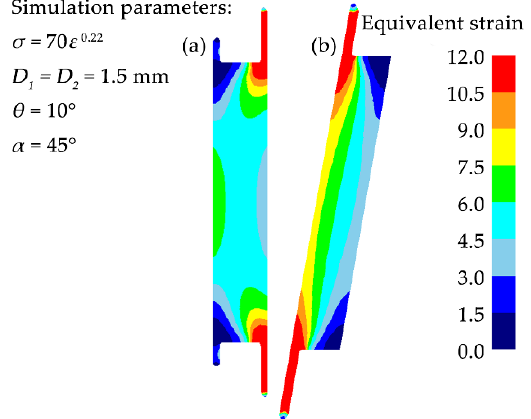
Figure 3. Distribution of equivalent strain across the vertical section of samples during t -HPS: ( a ) pressurized on both ends of the tube, ( b ) pressurized using the wedge effect.